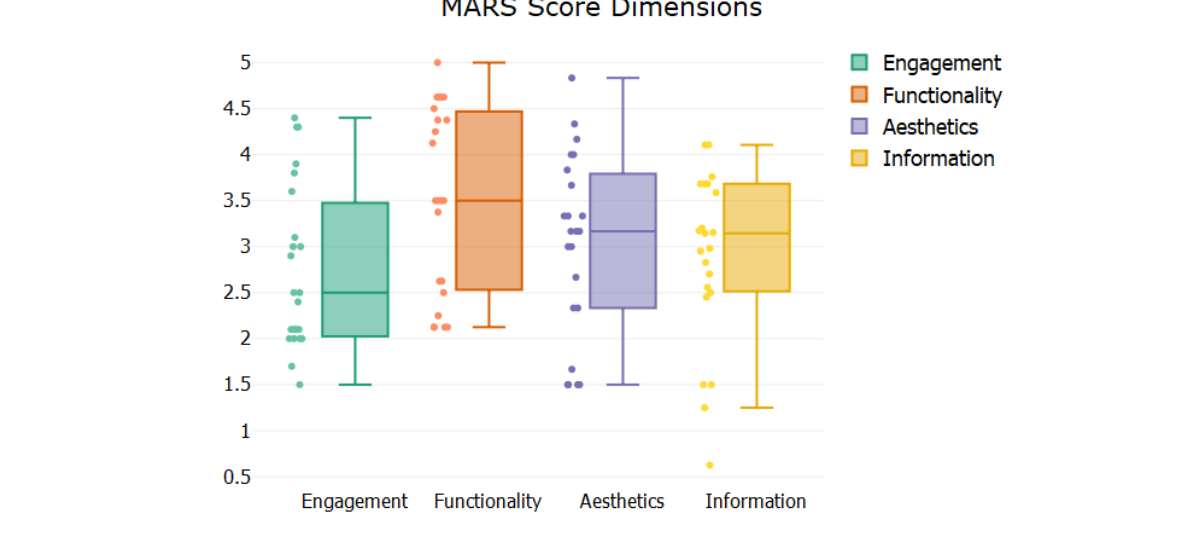
Figure 3. Mobile App Rating Scale (MARS) dimension scores. Each point represents the score for an individual app. The box plot shows the median, first, and third quartiles and minimum and maximum